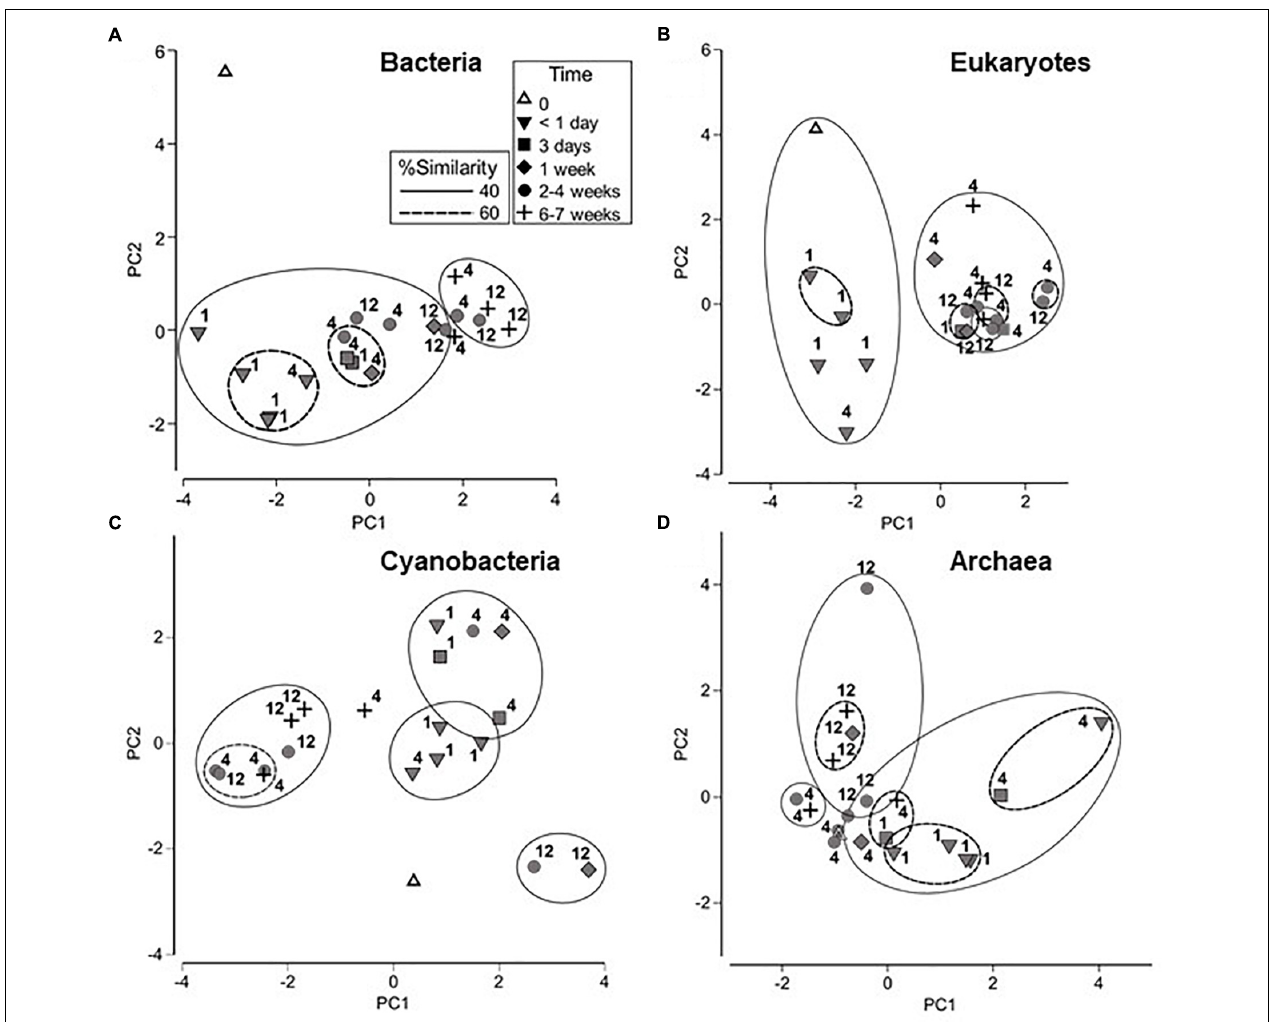
FIGURE 2 | Principle component analyses (PCA) of microbial community fingerprints with overlaid cluster percentage resemblance: (A) bacterial tRFLP; (B) eukaryotic tRFLP; (C) cyanobacterial ARISA, and (D) archaeal tRFLP. Numbers signify the location of the sampling site, i.e., 1, 4, or 12 m from the source point of the water